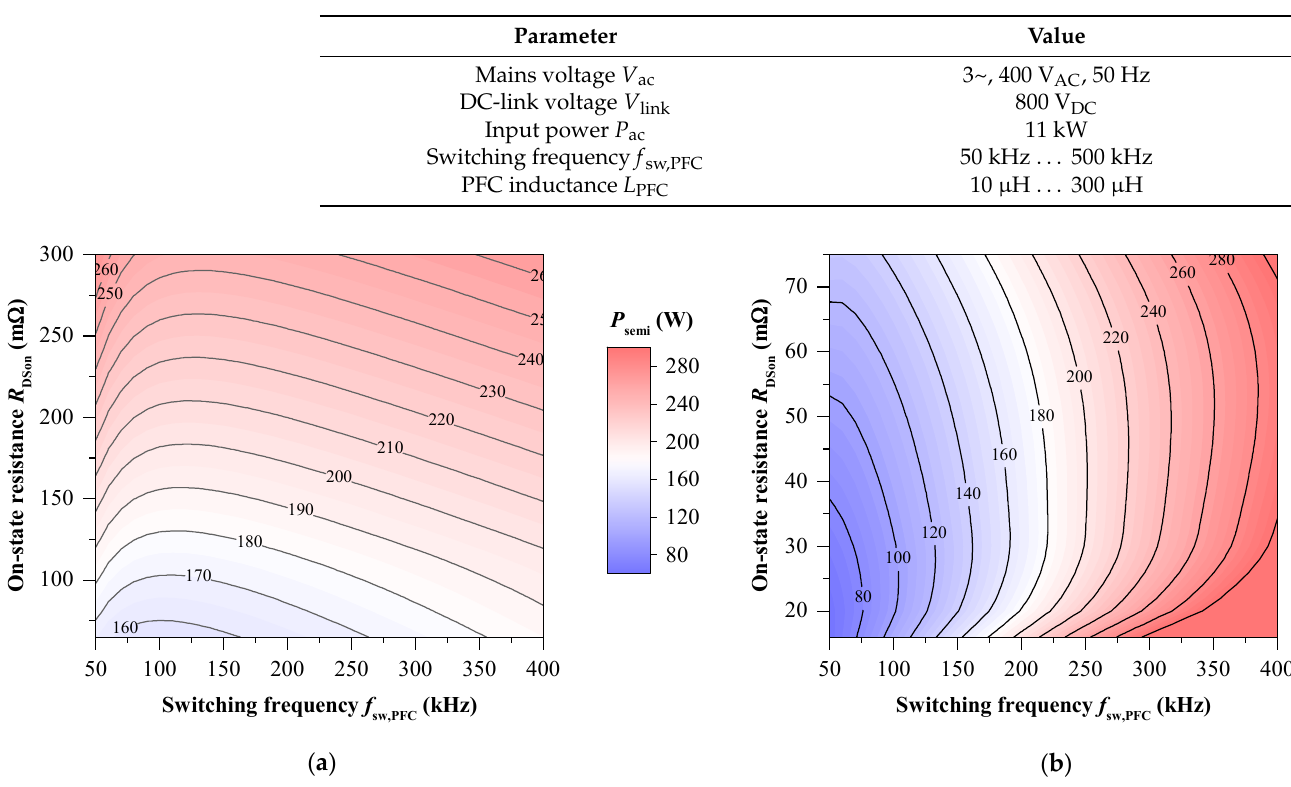
Figure 3. Distribution of the total semiconductor losses P semi versus the switching frequency f sw,PFC and the drain-source on-resistance R DSon of the SiC MOSFET for ( a ) the V IENNA topology with L PFC = 60 µH (including mains and freewheeling diodes) and ( b ) the 6S-Boost topology with L PFC = 120 µH.